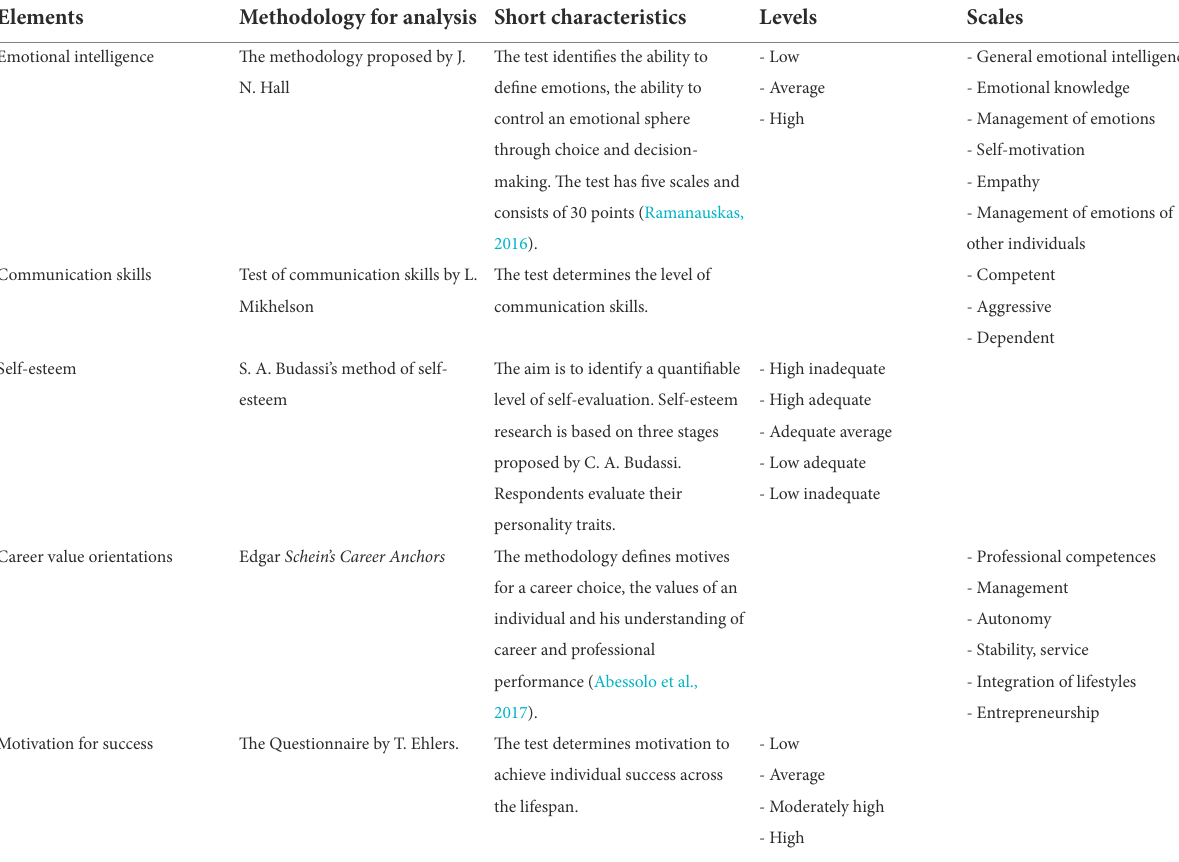
TABLE 2 Elements of the career